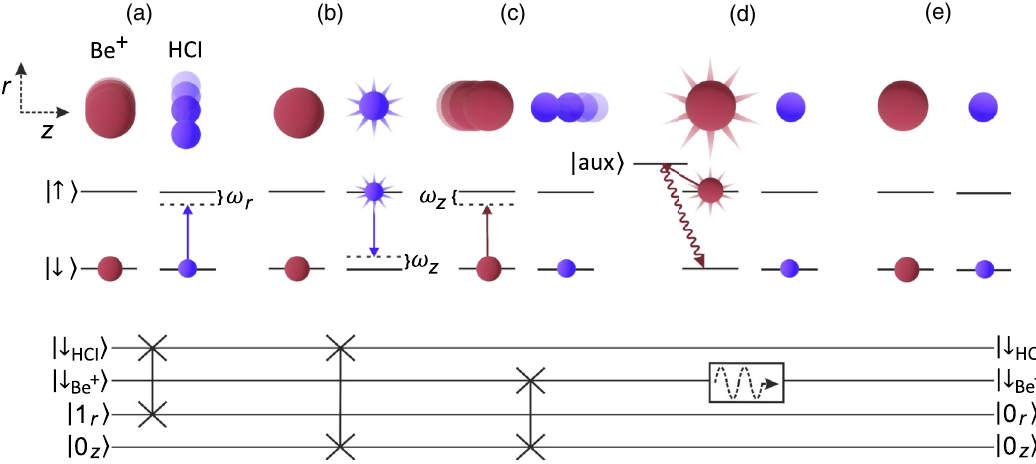
FIG. 2. Upper diagrams: scheme of the quantum-logic sideband cooling sequence representing the state of the ion crystal before each of the depicted laser pulses is applied. The energy level diagrams are not to scale. Pulses (a) and (b) on the HCI (purple symbols) swap a phonon from one of the WCR modes ( r ) into the axial out-of-phase mode ( z ) through the excited electronic state of the HCI. Pulse (c) on the Be þ ion (red symbols) removes the added phonon from the axial out-of-phase mode and converts it into an electronic excitation of the Be þ ion. Pulse (d) dissipatively resets the Be þ to its initial electronic state through spontaneous decay, completing the sequence and ensuring unidirectionality and cooling. Solid arrows depict driven transitions; undulating arrows represent spontaneous decay. Here, j ↓ i and j ↑ i represent the ground and excited electronic states of the relevant ion, respectively, which are all long-lived with respect to the gate time. The state j aux i is short-lived with a natural lifetime on the order of 10 ns. Lower diagrams: representation of the sequence as a quantum circuit composed of a series of SWAP quantum gates. Here, j 1 i i and j 0 i i represent the presence and lack of a phonon in mode i ,